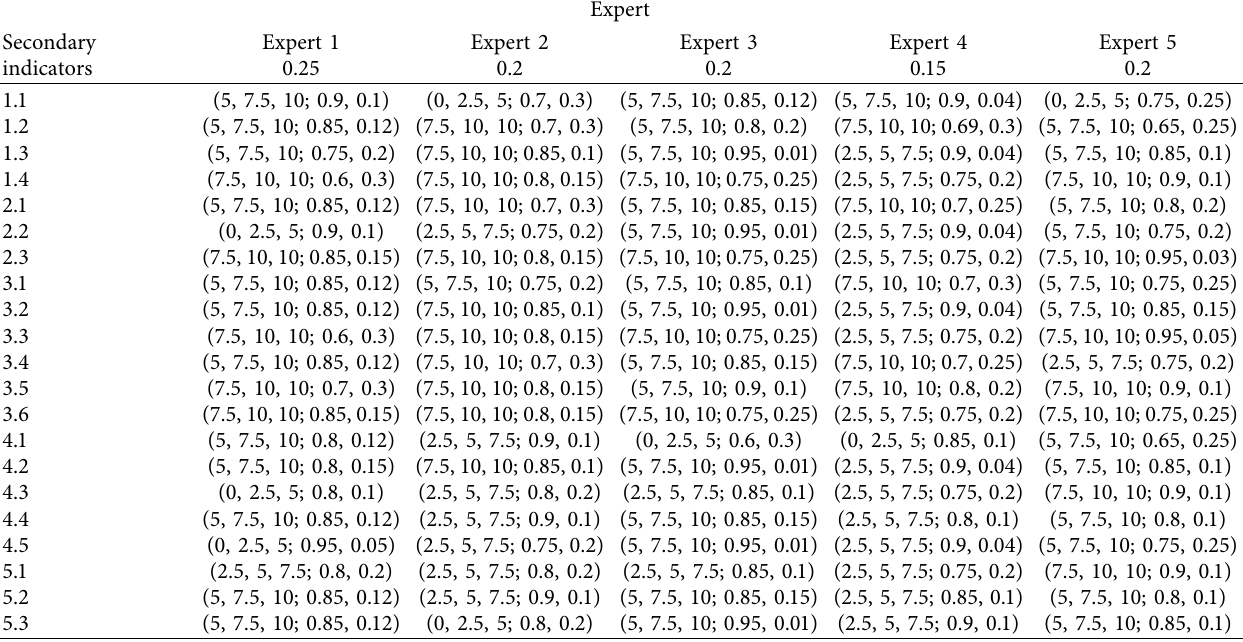
Table 3: Expert’s evaluation of secondary